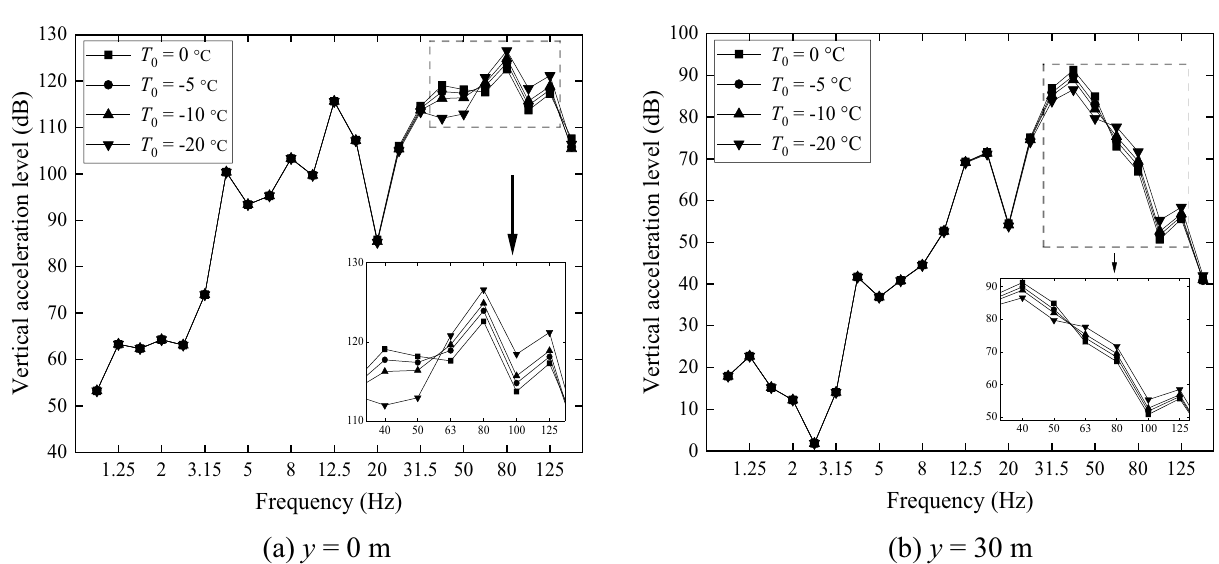
Figure 22. Ground vibration acceleration level in one-third octave bands at x = 0, ( a ) y = 0 m and ( b ) y = 30 m. Only the dependence of fastener stiffness and damping on temperature is